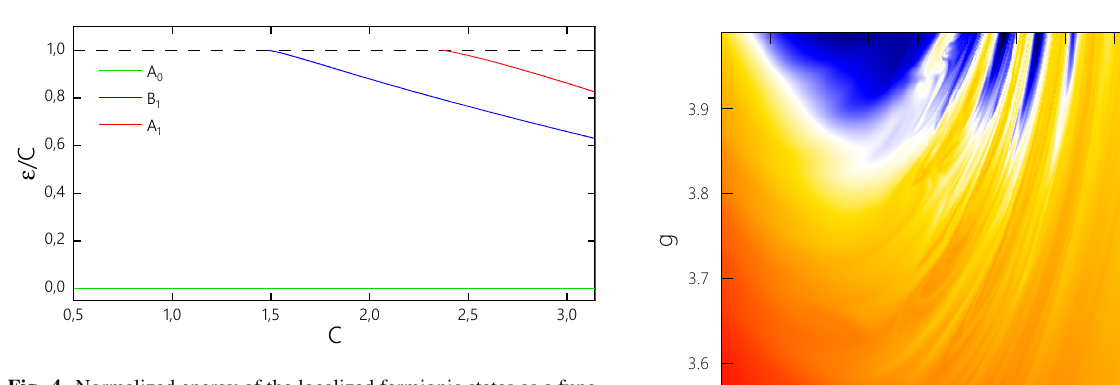
Fig. 4 Normalized energy of the localized fermionic states as a func- tion of the Yukawa coupling parameter C at m = 0 and g = 1 with backreaction